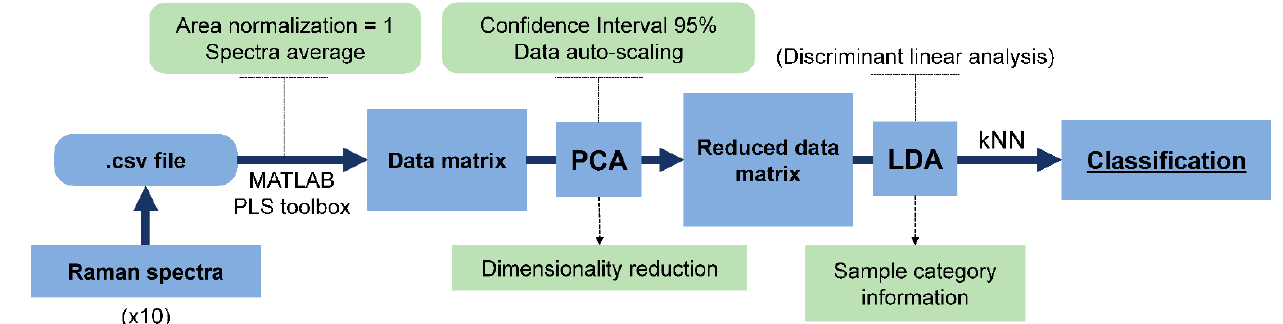
Figure 1. Data processing scheme of Raman spectra.